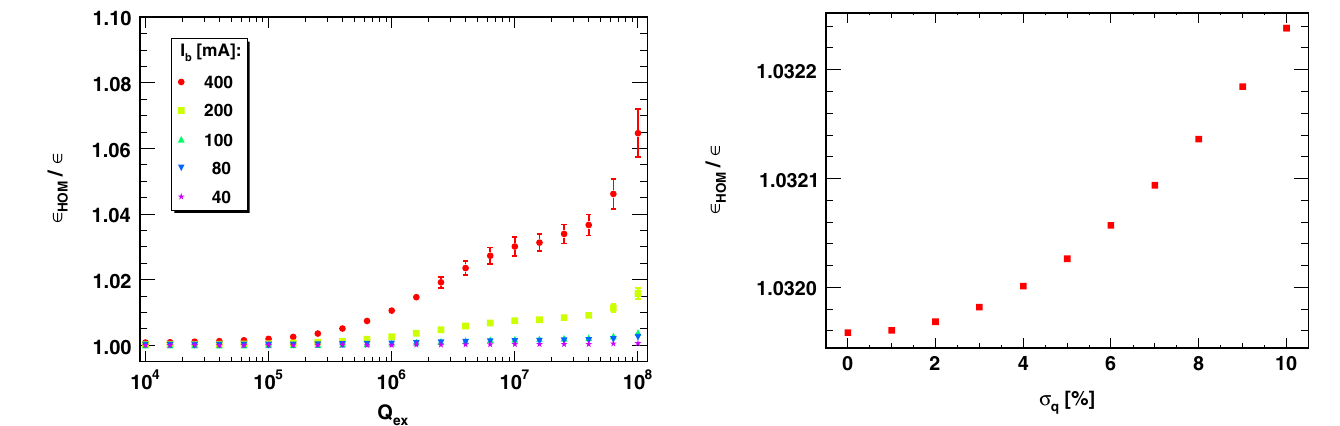
FIG. 28. Average transverse phase space increase of the beam and different beam currents h I against the damping Q ex one HOM per cavity is present for 100 linacs. The influence of ¼ 10 5 and is proportional to h I the HOM rises above Q ex ¼ 10 7 is due to the pulse period plateau around Q ex